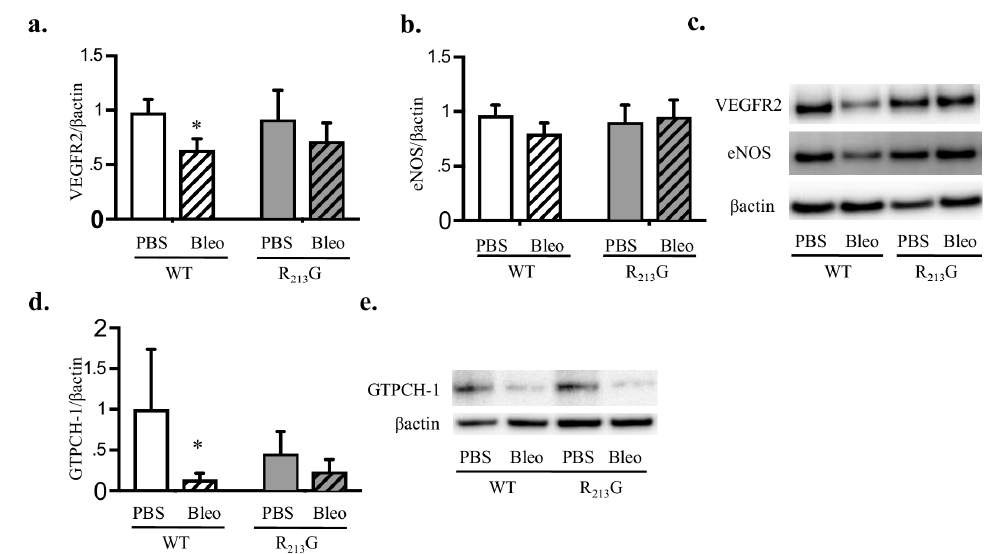
Figure 7. Bleomycin decreased vascular endothelial growth factor receptor 2 (VEGFR2) and guanosine triphosphate cyclohydrolase-1 (GTPCH-1) levels in WT mice. VEGFR2, endothelial nitric oxide synthase (eNOS) and GTPCH-1 protein content in the lung were evaluated by western blot analysis in WT and R 213 G mice at 22 days of age after exposure to PBS (10 μ L for 9 doses) or Bleomycin (3 units/kg/dose dissolved in 10 μ L of PBS for 9 doses). 25 μ g lung protein was loaded onto the gels. Representative blots are shown along with optical density normalized to β -actin and expressed relative to WT control mice. ( a ) VEGFR2 ( b ) eNOS ( c ) Representative blots for VEGFR2 and eNOS ( d ) GTPCH-1, ( e ) Representative blot for GTPCH-1 * p < 0.05 vs. WT PBS, by two-way ANOVA, n = 5–6 for all groups.